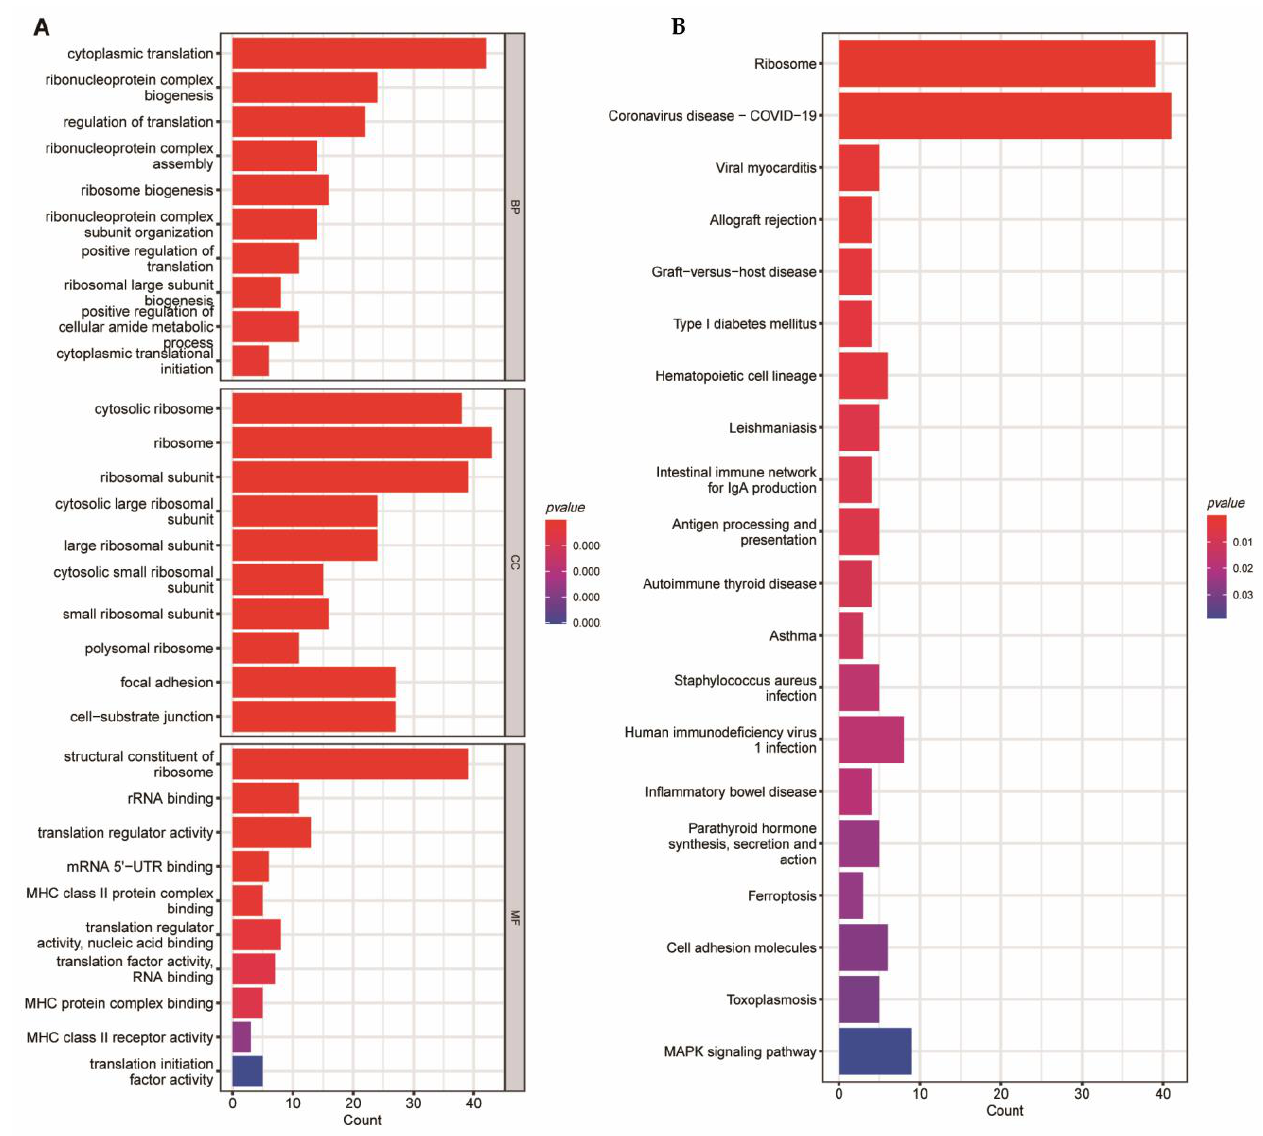
Figure 6. Analysis of GO and KEGG features. ( A ) BP, biological processes; CC, cellular components; MF, molecular functions of enrichment in the N gene set. ( B ) KEGG enrichment results in the N gene set.